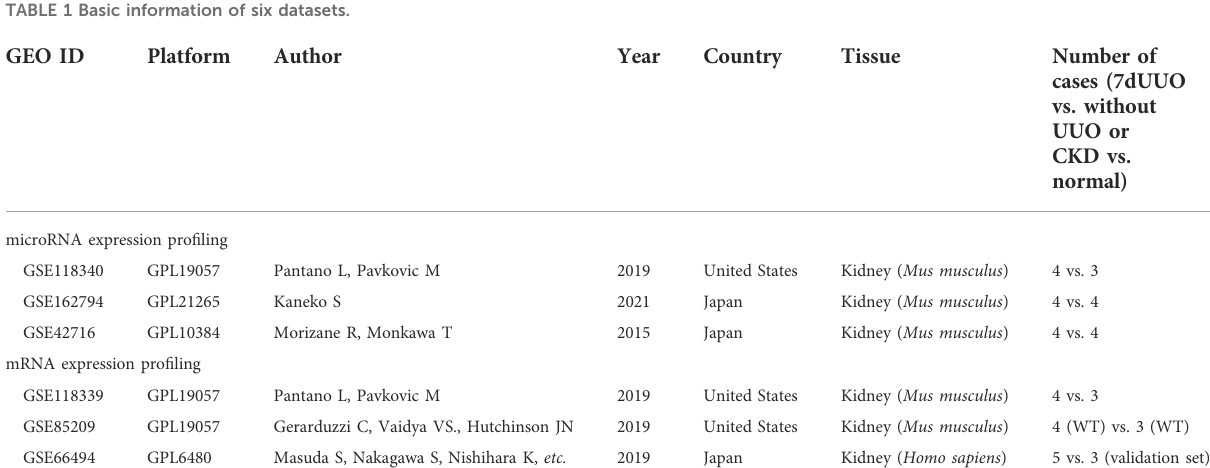
TABLE 1 Basic information of six